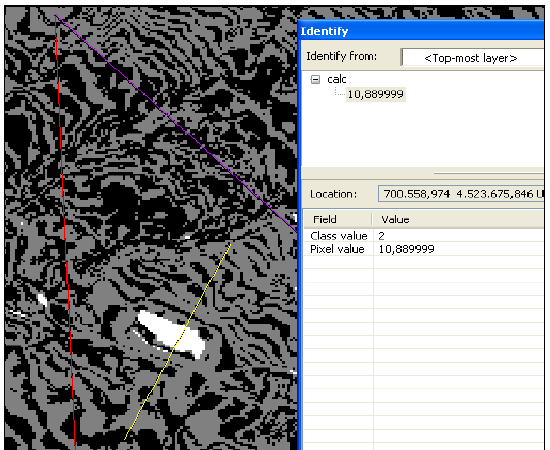
Figure 17. Differences between two DEMs (test